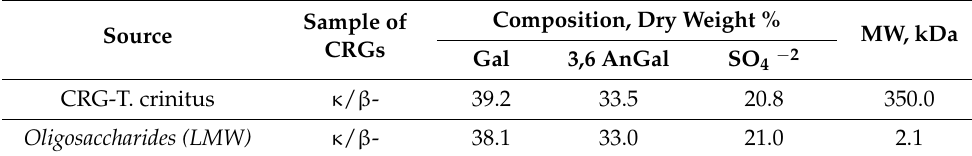
Table 1. Chemical composition of κ / β -carrageenans. Composition, Dry Weight Sample of Source CRGs